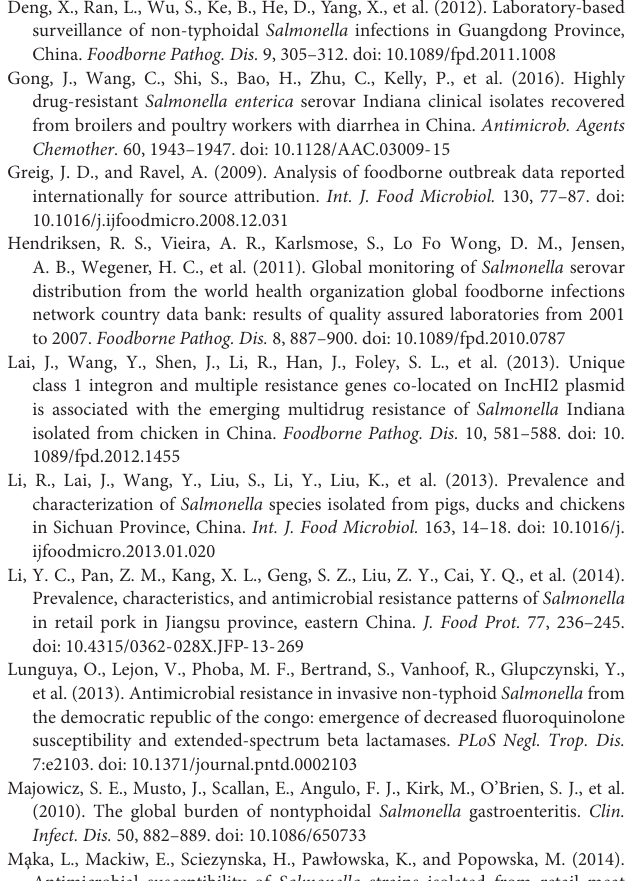
FIGURE S1 | Map of China showing the sampling locations (provinces and cities) of the current study. TABLE S1 | The sampling sites and time of the current